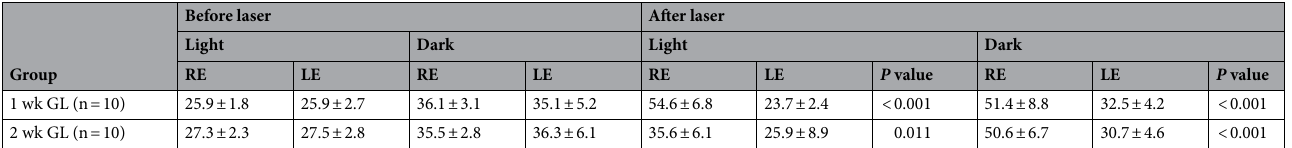
Table 1. Average light and dark phase IOP reading before and after trabecular laser photocoagulation. Baseline IOP readings were recorded for 1 week prior to trabecular laser photocoagulation. Significant increase in average light and dark IOP readings in the eyes at 1 week and 2 weeks after photocoagulation was noted when compared to contralateral control eyes ( P < 0.05). All IOP readings are represented as mean ± SD. RE, right eye; LE, left eye; 1 wk GL, 1 week glaucoma; 2 wk GL, 2 weeks